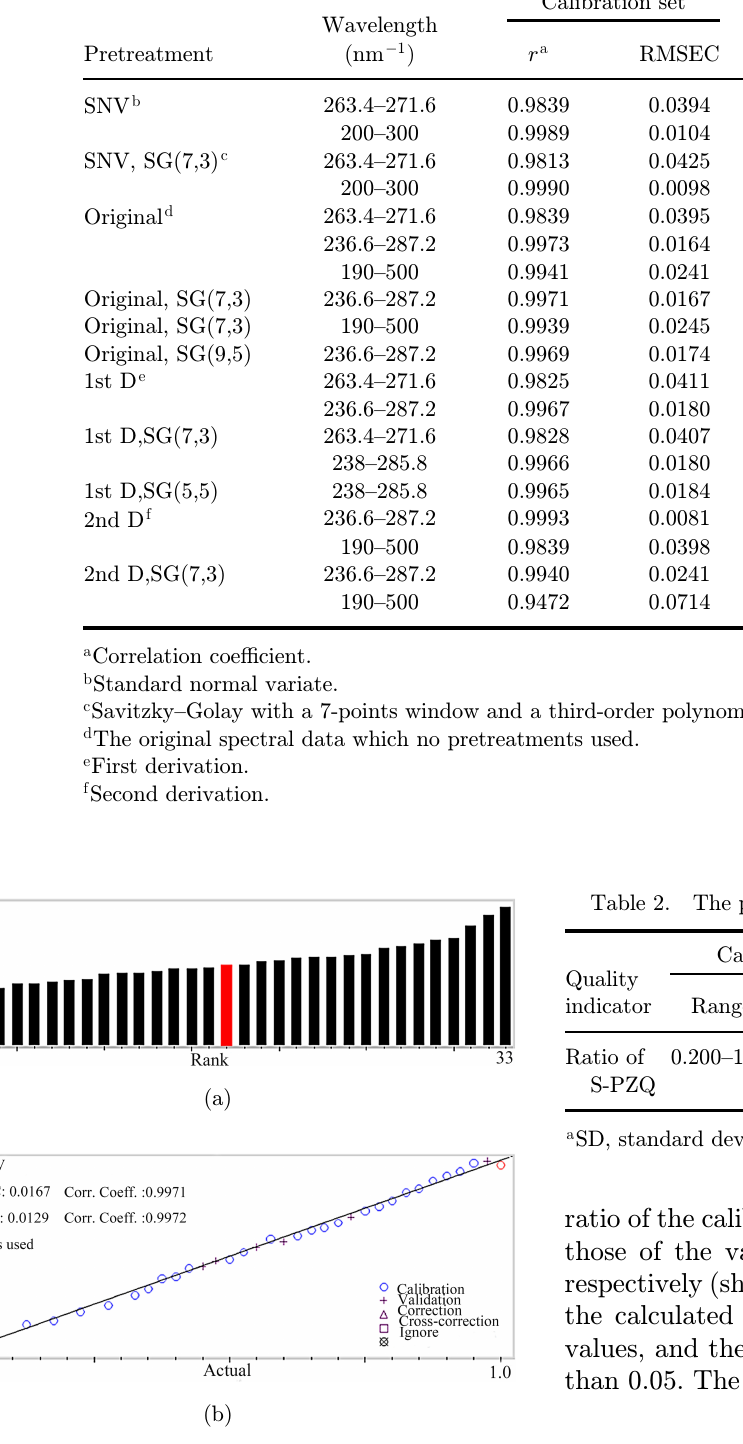
Fig. 3. (a) The result showed that no outliers were found. (b) The result of PLS analysis including the correlation coe±cient of calibration set and validation set: 0.9971 and 0.9972. The RMSEC and the RMSEP values were 0.0167 and 0.0129, respectively. Five factors were used for the model.